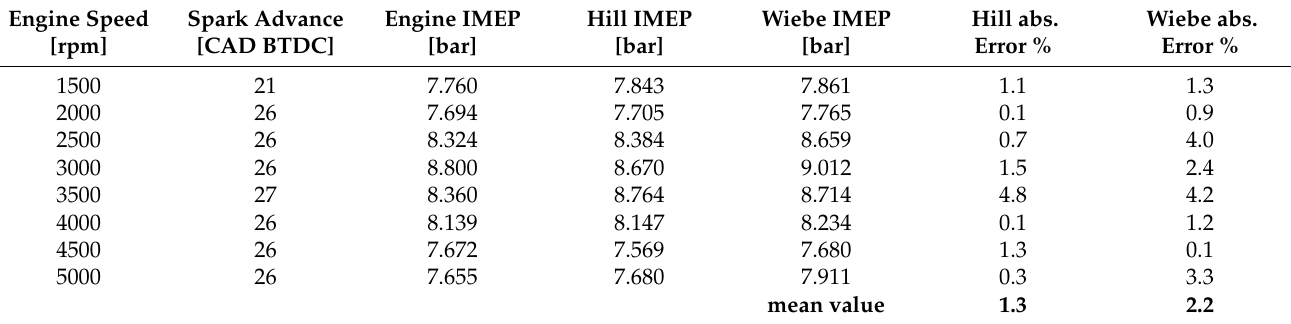
Table 12. Experimental and simulated IMEP with absolute prediction errors (80% NG; MAP = 1 bar).